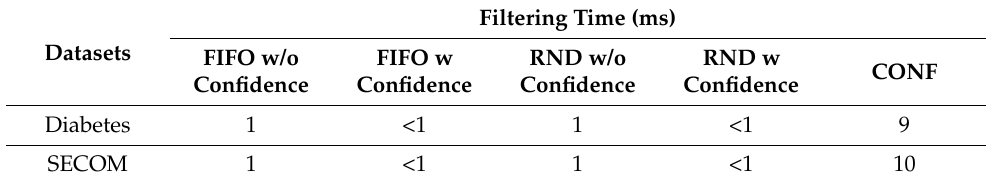
Table 6. Filtering time performance on the edge device with different strategies.